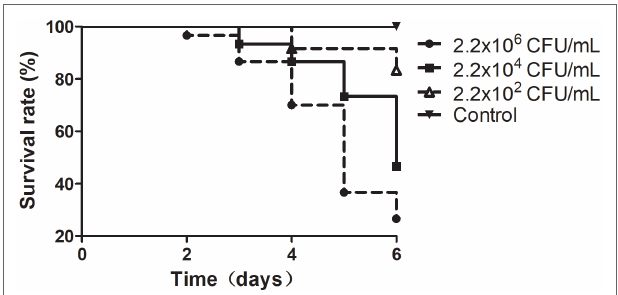
FIGURE 1 | Survival rates of the shrimp infected by Vibrio sp. Va-F3. Survival rates of the shrimp were calculated after cocultured with Vibrio strains for 1 week. The control group was set as no Vibrio strain included, and the experimental groups included 500 ml of bacterial suspension with three different bacterial concentrations, as 2.2 × 10 2 , 2.2 × 10 4 , and 2.2 × 10 6